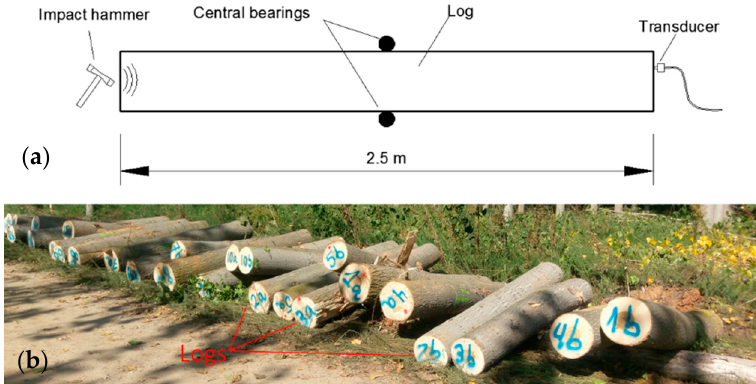
Figure 5. Resonance inspection on logs; the experimental setup ( a ); and image of the inspected logs ( b ).